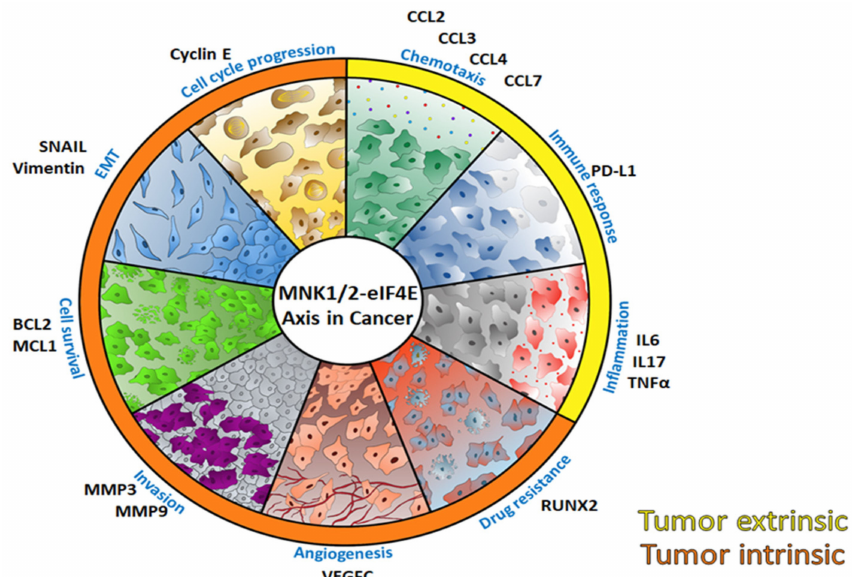
Figure 3. Schematic highlighting the processes that are regulated by the MNK1 / 2-eIF4E axis. Tumor extrinsic processes are indicated by the yellow outer wheel and tumor intrinsic processes are indicated by the orange outer wheel. Proteins whose mRNA is a ff ected by phosphorylation of eIF4E are in